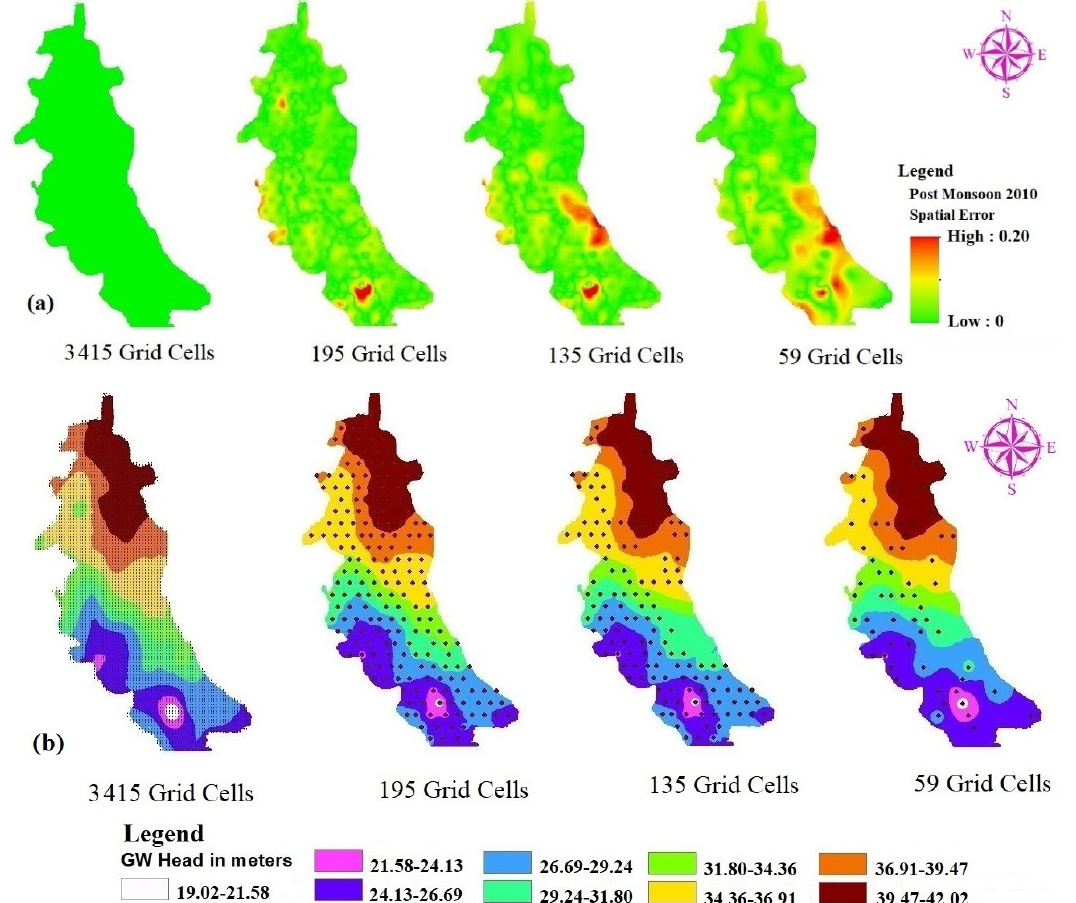
Figure 10. ( a ) Normalized standard error for different numbers of observation points. ( b ) Head contour classification using different numbers of observation points.